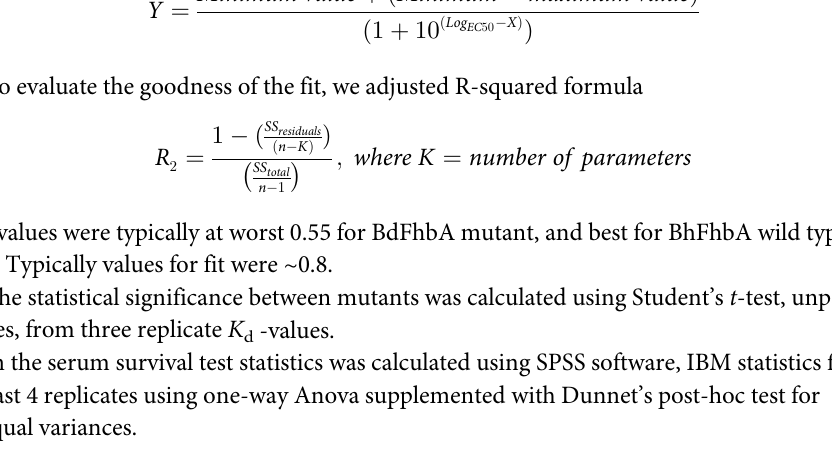
S1 Fig. BhFhbA:FH19-20 interfaces in the crystal. ( a ) Two non-overlapping interaction interfaces of BhFhbA proteins with the FH19-20 fragment are observed in the crystal. ( b ) Bio- logical interface. ( c ) Crystal symmetry interface formed because of packing of protein mole- cules in the crystal. S2 Fig. Analysis and visualization of multiple binding molecules to the FH19-20 fragment. (a) FH19-20 (blue) is represented with many biological molecules that were reported to bind FH19-20. The binding area of FhbA, OspE and sialic acid overlap. The C3d binding region on FH19 does not overlap with the secondary interface observed in the FhbA:FH19-20 co-crystals.